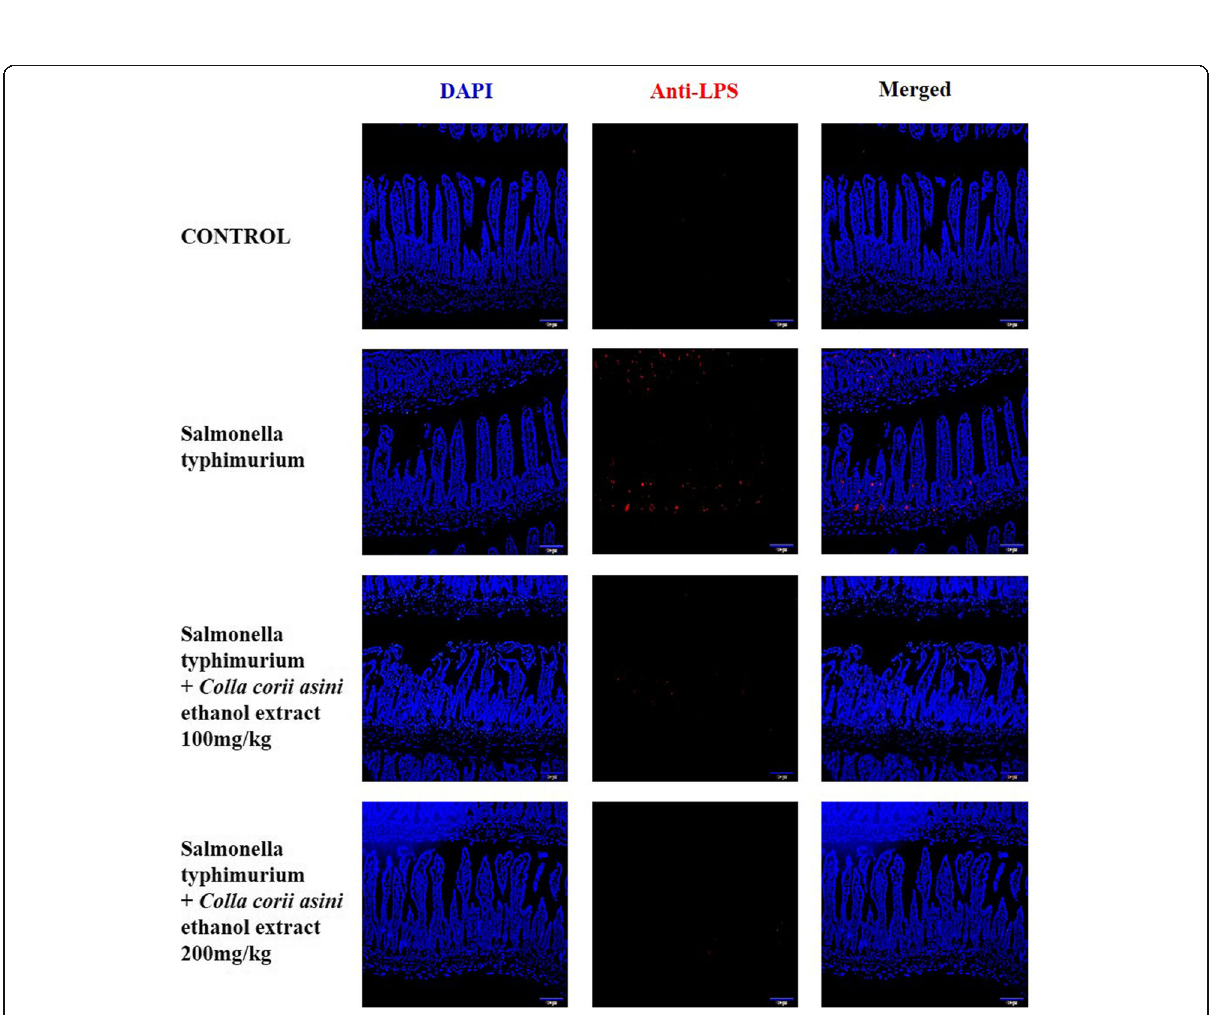
Fig. 5 Colla corii asini ethanol extract inhibited the invasion of S. typhimurium in mice intestines. ICR mice were orally infected with S. typhimurium and the small intestines were obtained. Serial sections of intestines were analyzed via IHC. Colla corii asini ethanol extract (200 mg/ kg) suppressed the invasion of bacteria compared with that in the group of mice treated with S. typhimurium